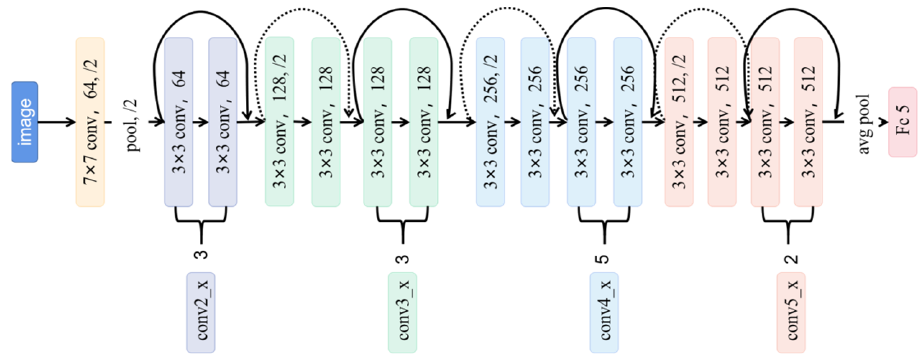
Figure 5. ResNet ‐ 34 model structure diagram. Figure 5. ResNet-34 model structure